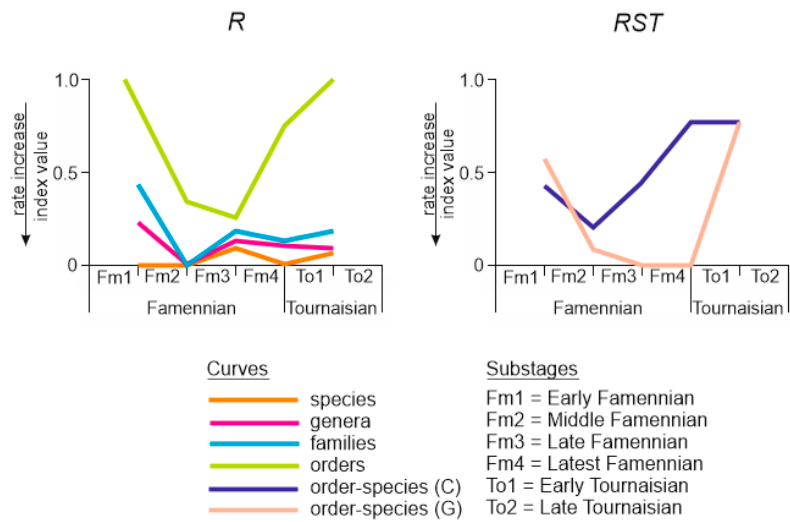
Figure 4. Rates of changes among the assemblages of the studied bryozoans (created by the authors, see Table 2 for numbers).